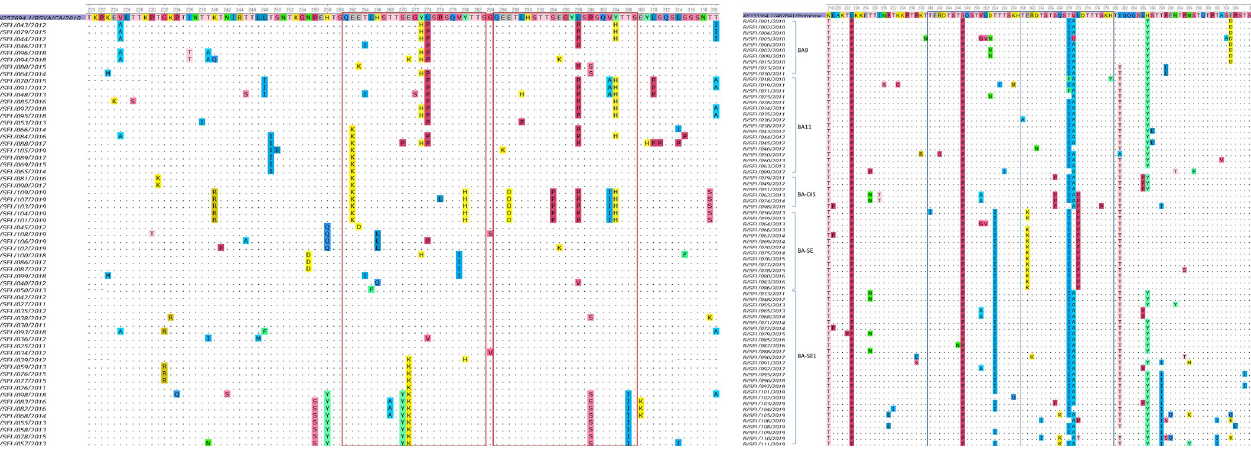
Fig 5. Deduced amino acid sequences in the 2 nd HVR of RSV G gene of Seoul RSV-A ON1 and RSV-B BA genotype. Amino acid sequences alignment of the partial G gene of RSV, (A) RSV-A ON1 and (B) RSV-B BA genotype. Sequences are expressed as RSV subtype (A or B)/city (Seoul, SEL)/sample number/ collected year. Alignments are shown, and residues are numbered relative to sequences of (A) prototype ON1 strain ON67-1210A (GenBank accession no. JN257693) and (B) prototype strain BA strain BA4128/99B (GenBank accession no. AY333364). The two copies of 23 amino acid regions in the RSV-A group and 20 amino acid regions in the RSV-B group are framed in red and blue, respectively. Identical residues were indicated by dots. To enable convenient visualization of shared mutations, the RSV-A strains were arranged in the same order as depicted in the maximum likelihood (ML) tree. On the other hand, the RSV-B strains were listed according to their clusters in their trees (BA9, BA11, BA-DIS, BA-SE, and